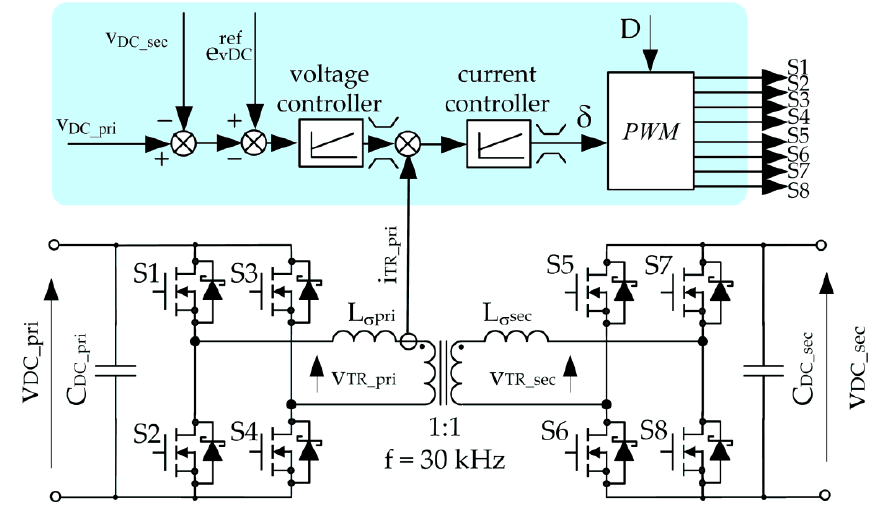
Figure 13. The single DAB DC-DC converter and its control system.